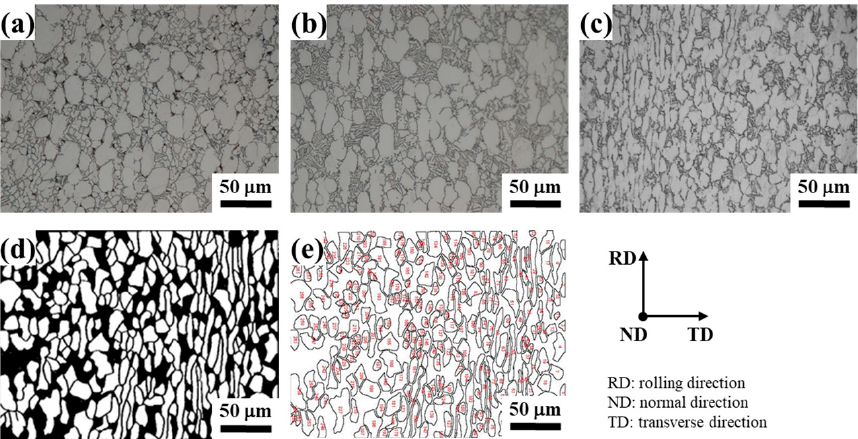
Figure 1. Optical micrographs of longitudinal cross-sections of samples and corresponding ImageJ analysis; ( a ) forged sample (FS), ( b ) rolled sample (RS), ( c ) homogeneously rolled sample (HS), ( d ) converting ( c ) to a binary image, and ( e ) converting ( c ) to an outline image.